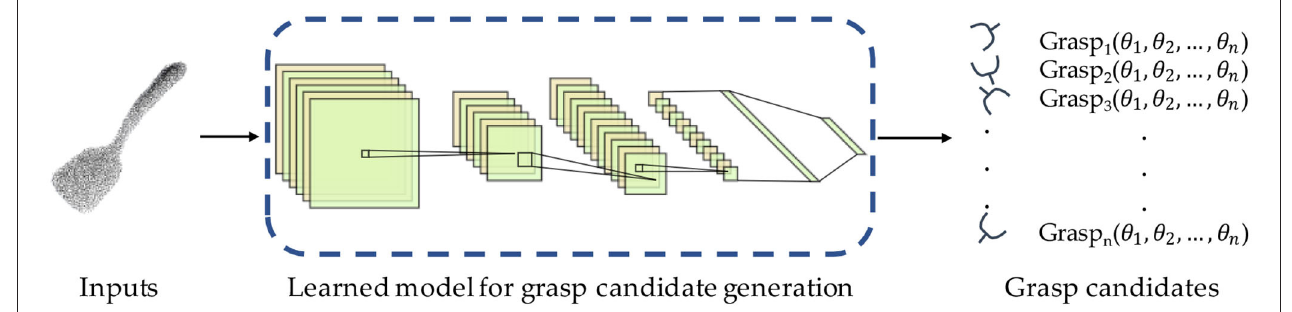
FIGURE 5 | Learning-based sampling (The spatula point cloud is from YCB